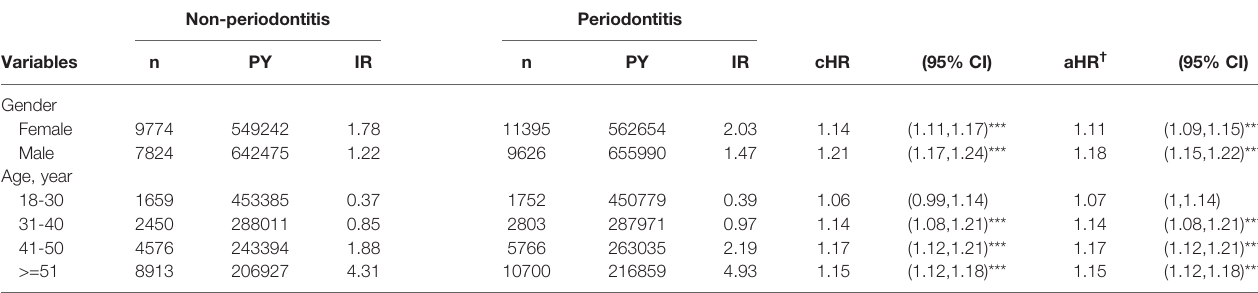
TABLE 3 | Subgroup analyses on risks of osteoarthritis following periodontitis, based on sex and age strati fi cation.